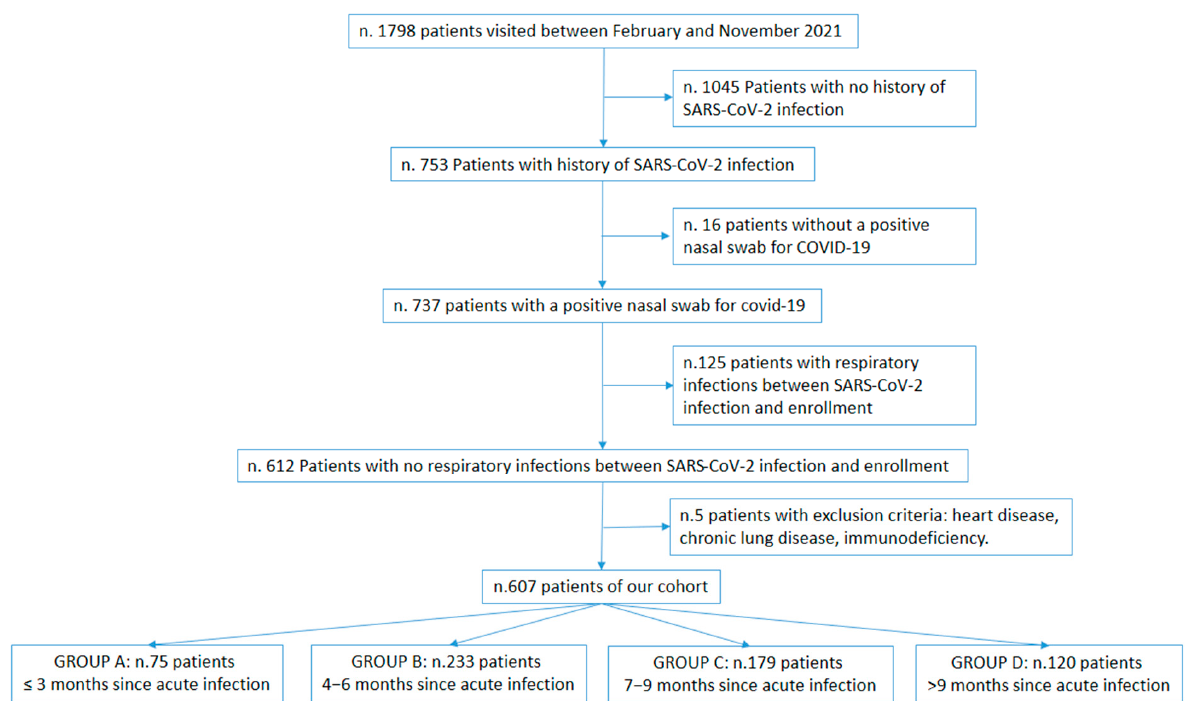
Figure 1. Enrolment flow-chart.